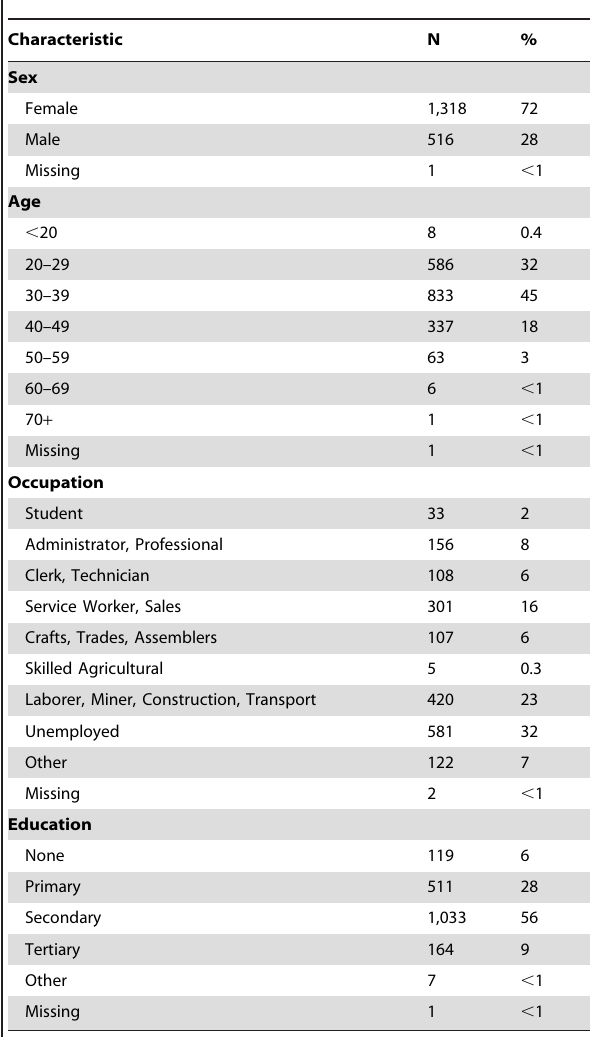
Table 2. Characteristics of participants of the isoniazid tuberculosis preventive therapy trial for whom comprehension quizzes were